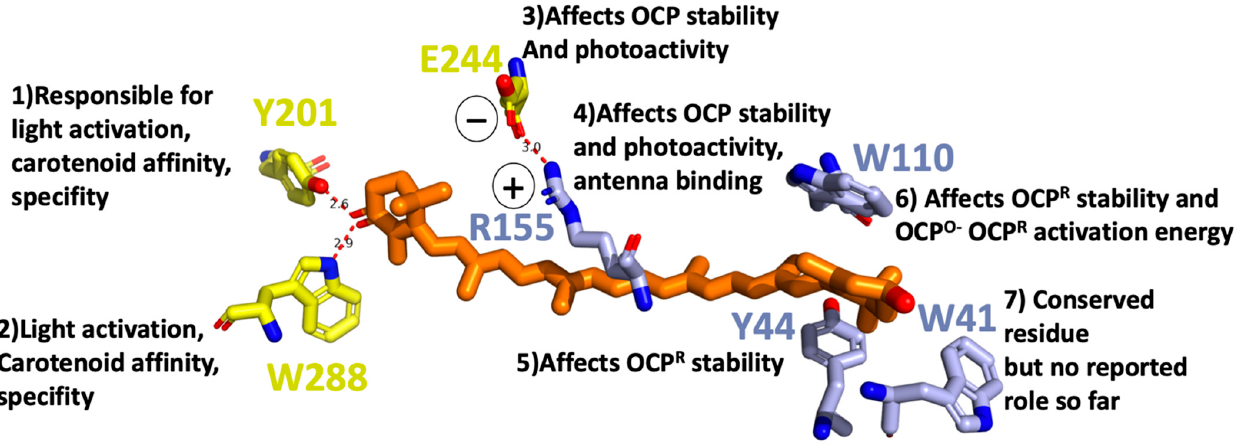
Figure 2. Tentative role of individual amino acids in OCP light activation in a close Car vicinity based on mutagenesis studies